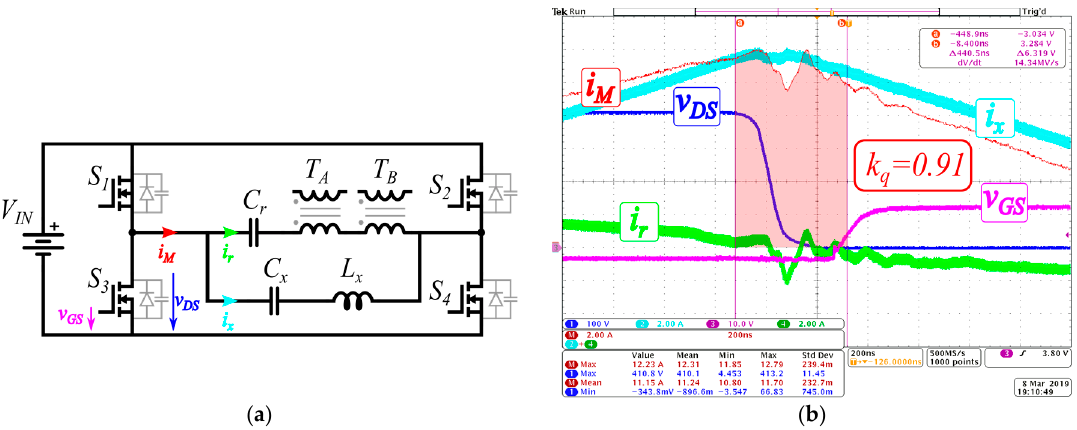
Figure 25. ( a ) Measurement setup including auxiliary circuit; ( b ) ZVS experimental results at 500 W.